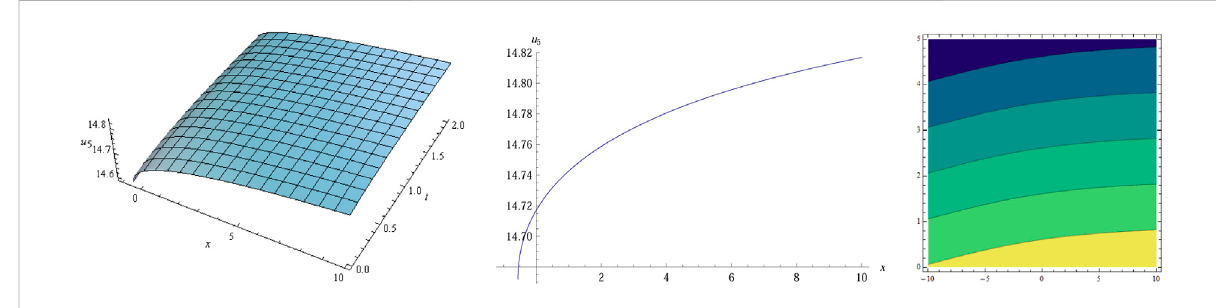
FIGURE 7 3D plot, 2D plot, and contour plot of u 5 with α (cid:2) 0 . 3 , β (cid:2) 0 .